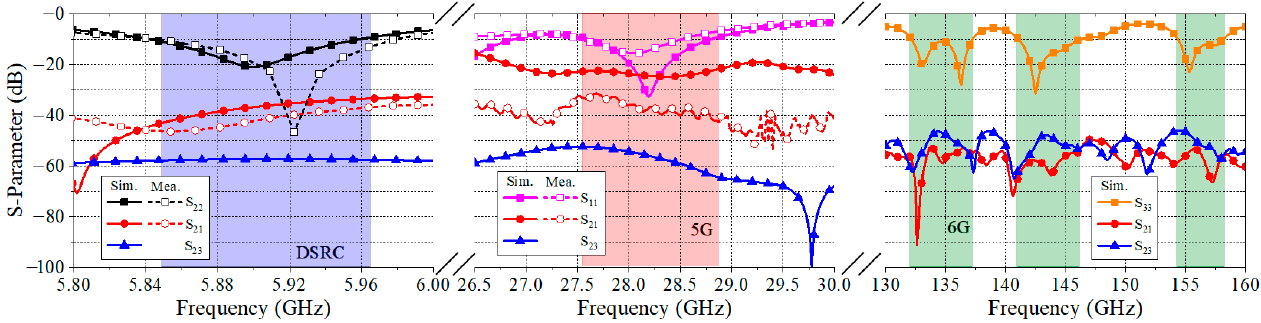
Figure 16. S-parameter of the developed triple-band antenna array.